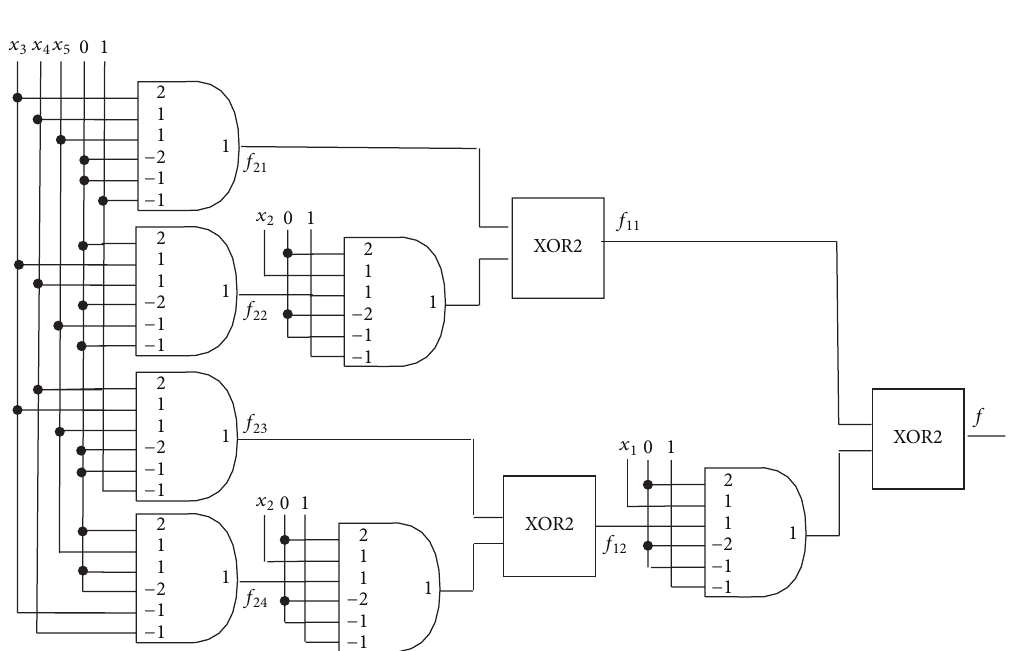
Figure 5: UTLG and XOR2 implementation of Example